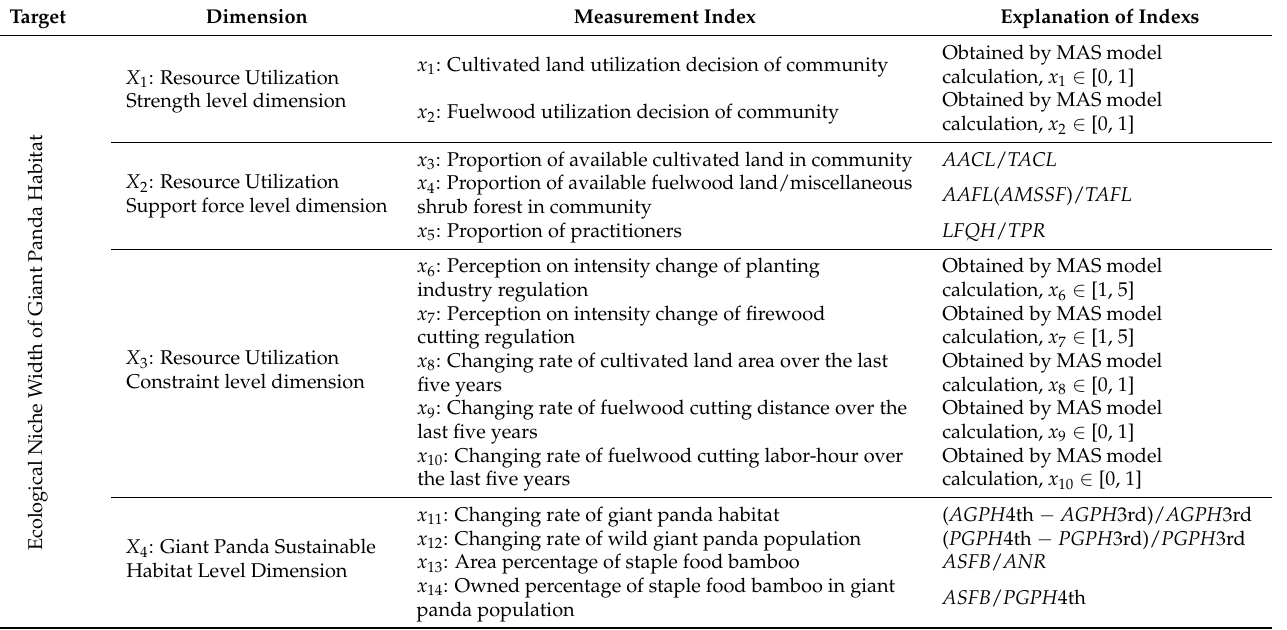
Table 1. Comprehensive evaluation index system of ecological niches at the habitat level of giant